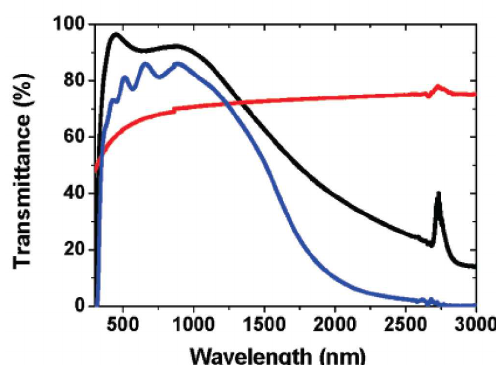
Figure 14. Transmittance comparison with respect to wavelength. Comparisons among ITO, FTO and graphene are shown. ITO, FTO, and graphene are marked by blue, black, and red, respectively. Reprinted with permission from [134]. Copyright (2008) American Chemical